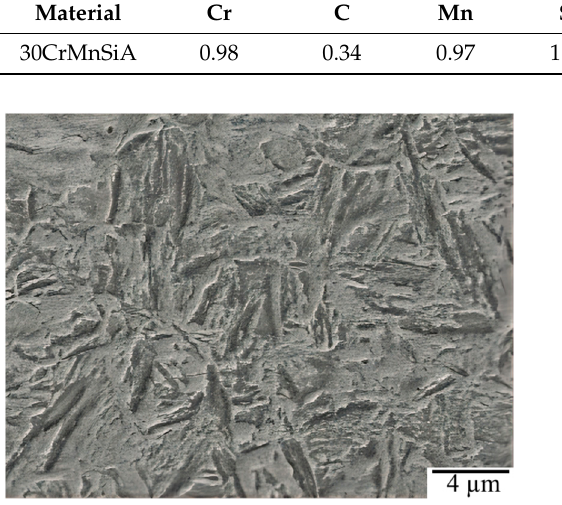
Table 1. Chemical composition of 30CrMnSiA Steel (wt. %).